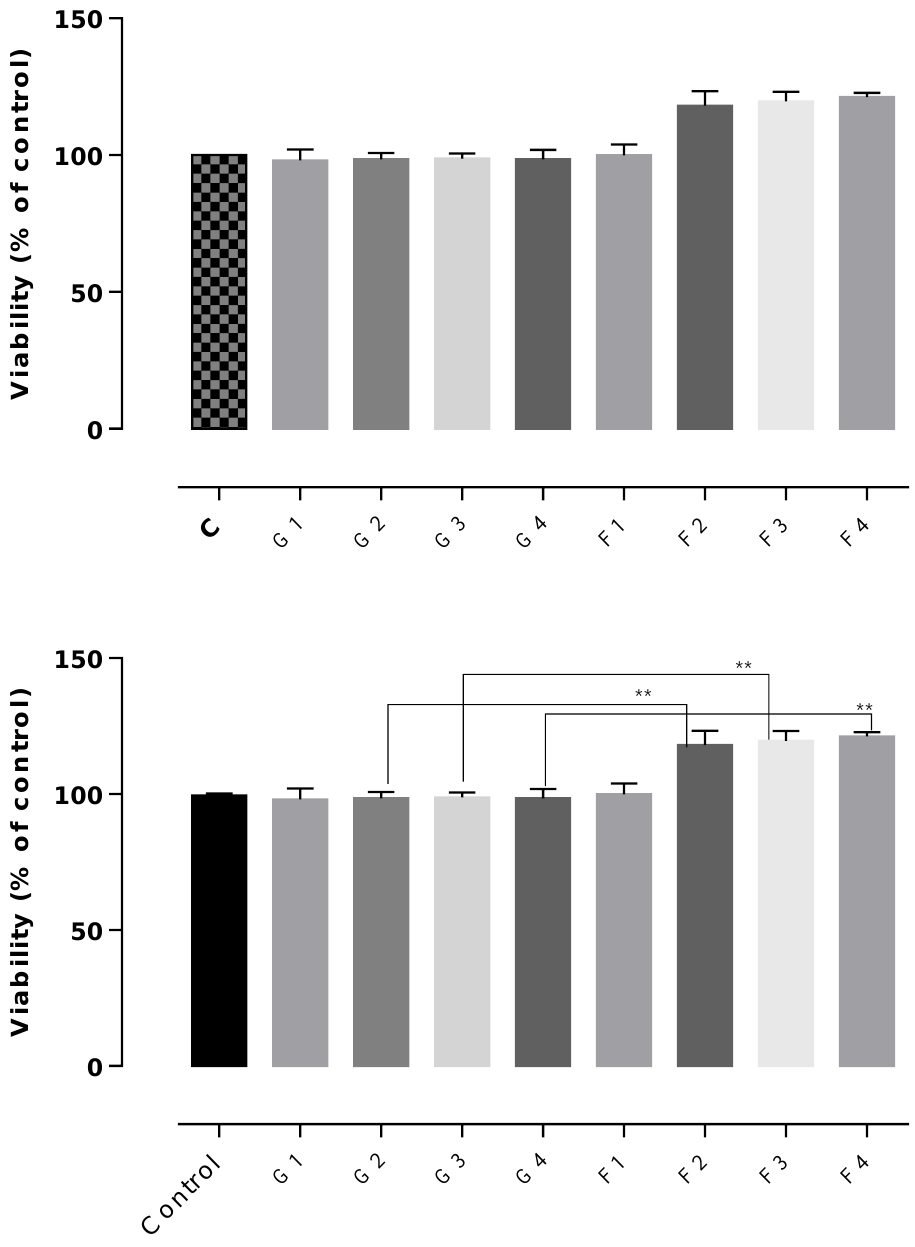
Figure 9. D1MSCs cells viability assessment after treatment with control gel and gel with Frankincense ® essential oil, where Control = D1MSCs cells in normal propagation medium; G1, 2, 3, 4 = the gel without essential oil in 4 different concentrations (2.4; 4.7; 7 and 9% ( v / v )); F = the gel with Frankincense ® essential oil in 4 different concentrations of gels (2.4; 4.7; 7 and 9% ( v / v )), ** p < 0.001.